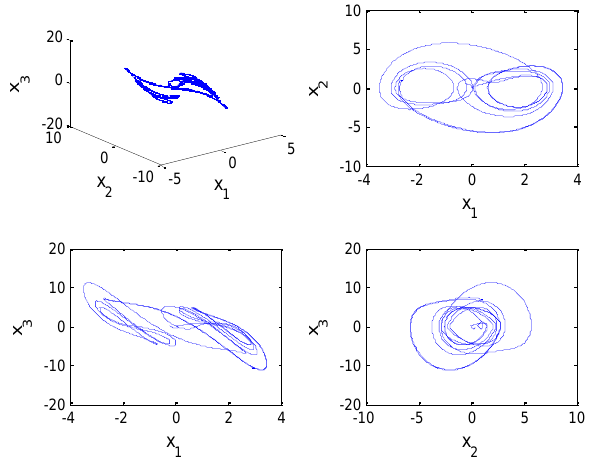
Figure 7. Phrase plots of x 1 , x 2 , and x 3